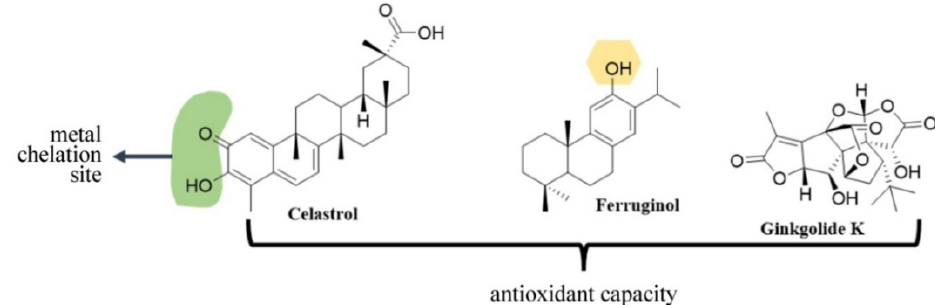
Figure 8. Structure of Terpenoids with neuroprotective activity. Green shadowing shows iron chelation sites; yellow shadowing shows free radical scavenger site. The APH-4 compound has anti-oxidant and metal chelating capacity; the latter not specified; In MT-20R the blue box shows the inhibition site for MAO-B.